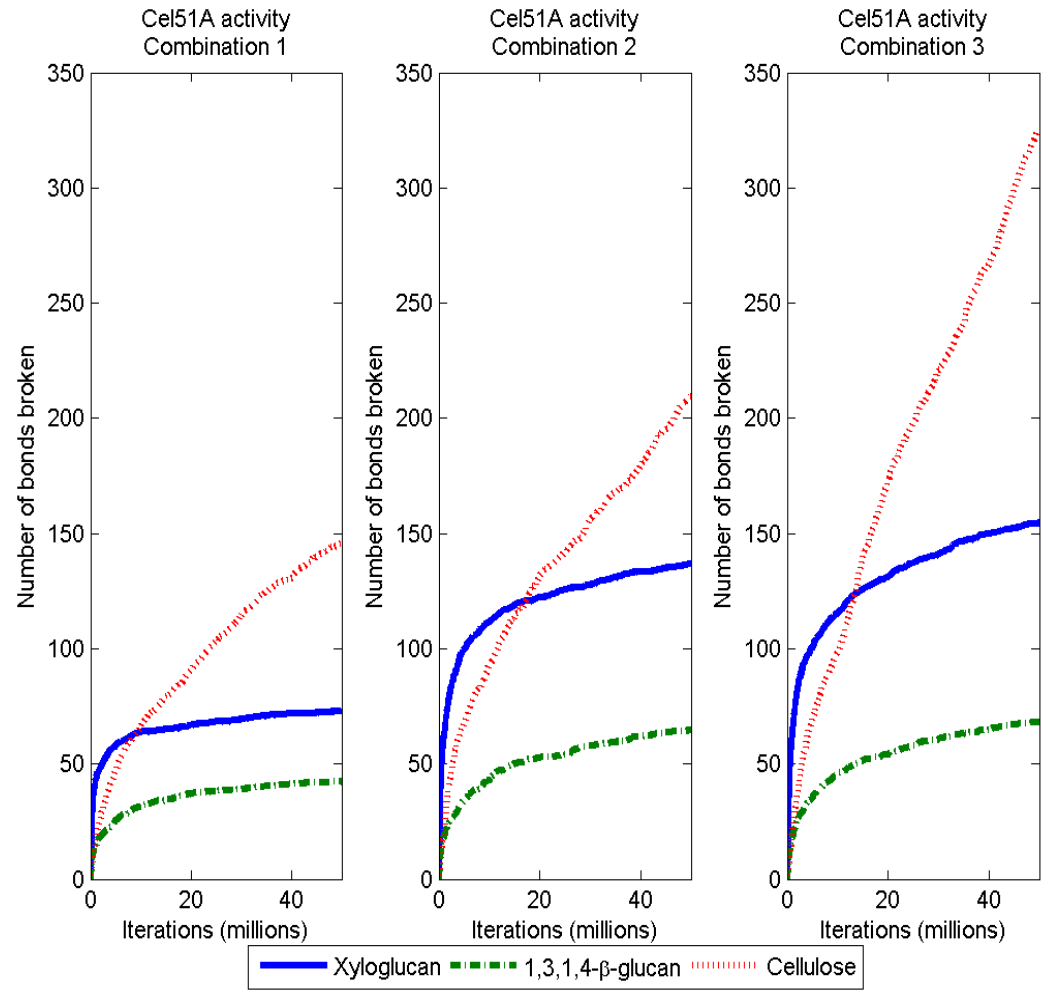
Figure 8. Simulation results showing the activity per 20 Cel51A enzymes on glucosidic bonds versus simulation progress (in iterations), for three enzyme combinations. Synergies existed both between Cel51A and Cel9D, and between Cel51A, Cel9D and endoxylanase 1. Combination 1: 40 Cel51A (endoglucanase) enzymes; Combination 2: 20 Cel51A (endoglucanase) and 20 Cel9D (exoglucanase) enzymes; Combination 3: 20 Cel51A (endoglucanase), 20 Cel9D (exoglucanase) and 20 endoxylanase 1 (endoxylanase with α -arabinofuranosidase activity)